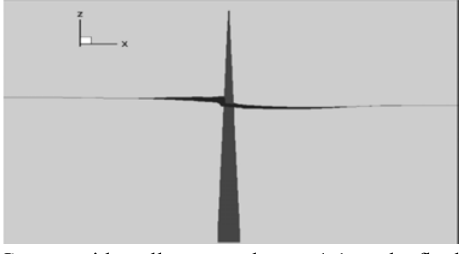
Fig.17 Variation of water surface in the X-Z